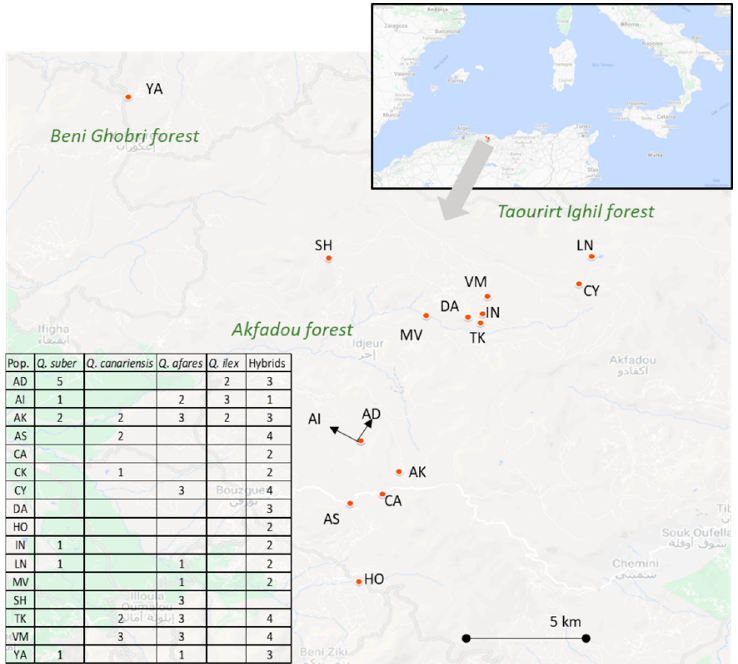
Figure 1. Geographical location of sampled populations and number of sampled trees. (Name of the locations: AD ‐ Adrar, AI ‐ Ait Aicha, AK ‐ Akfadou, AS ‐ Ait Salah, CA ‐ Col Ait Salah, CK ‐ Col Akfadou, CY ‐ Cynegetic centre, DA ‐ Damous, HO ‐ Houra, IN ‐ Intersection , LN ‐ Lac noir, MV ‐ Mehaga village, SH ‐ Sidi El Hadi, TK ‐ Tala Kittan, VM ‐ Vide Mehaga, YA ‐ Yakouren.